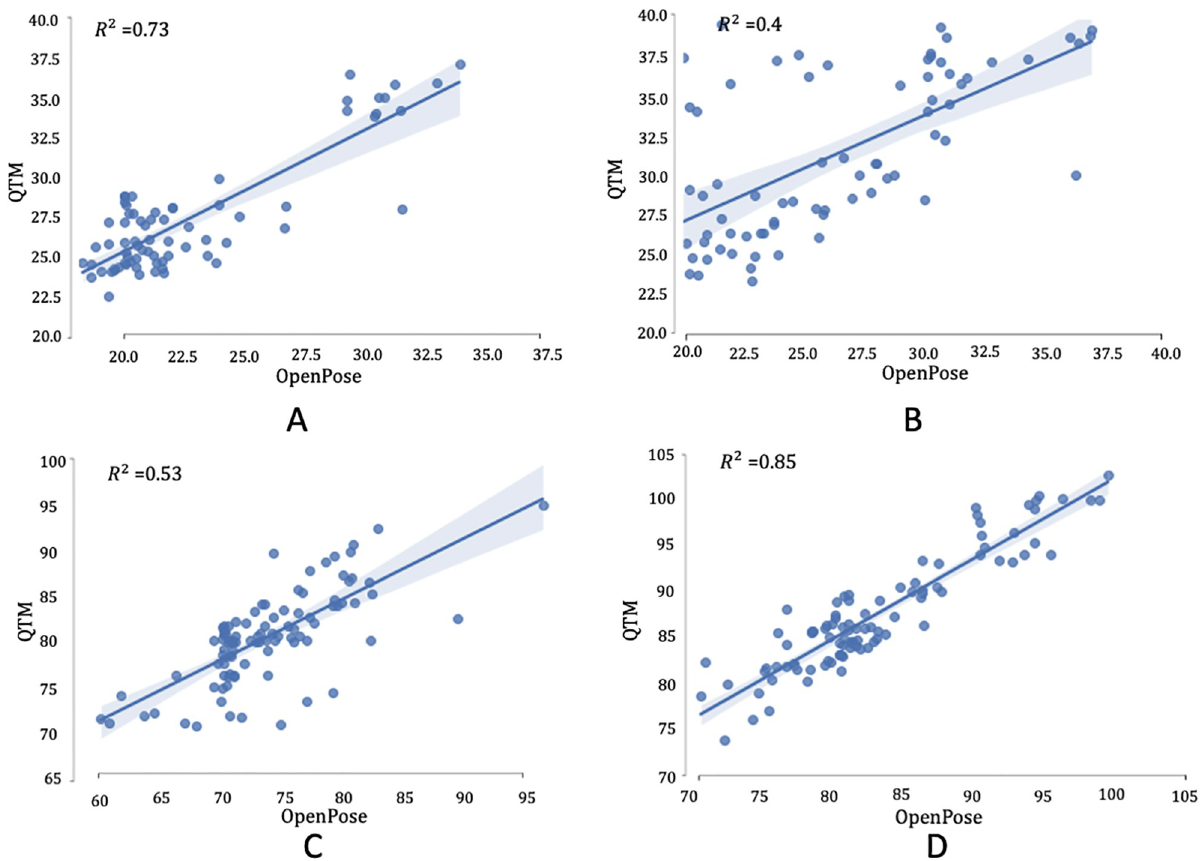
Fig 11. Linear regression. Linear regression plots of total active flexion for (A) abduction and adduction, (B) radial walking, (C) MCP flexion and (D) thumb opposition of the 2nd, 3rd, 4th and 5th digits for the metacarpophalangeal and proximal interphalangeal joints of the left and the right hands.